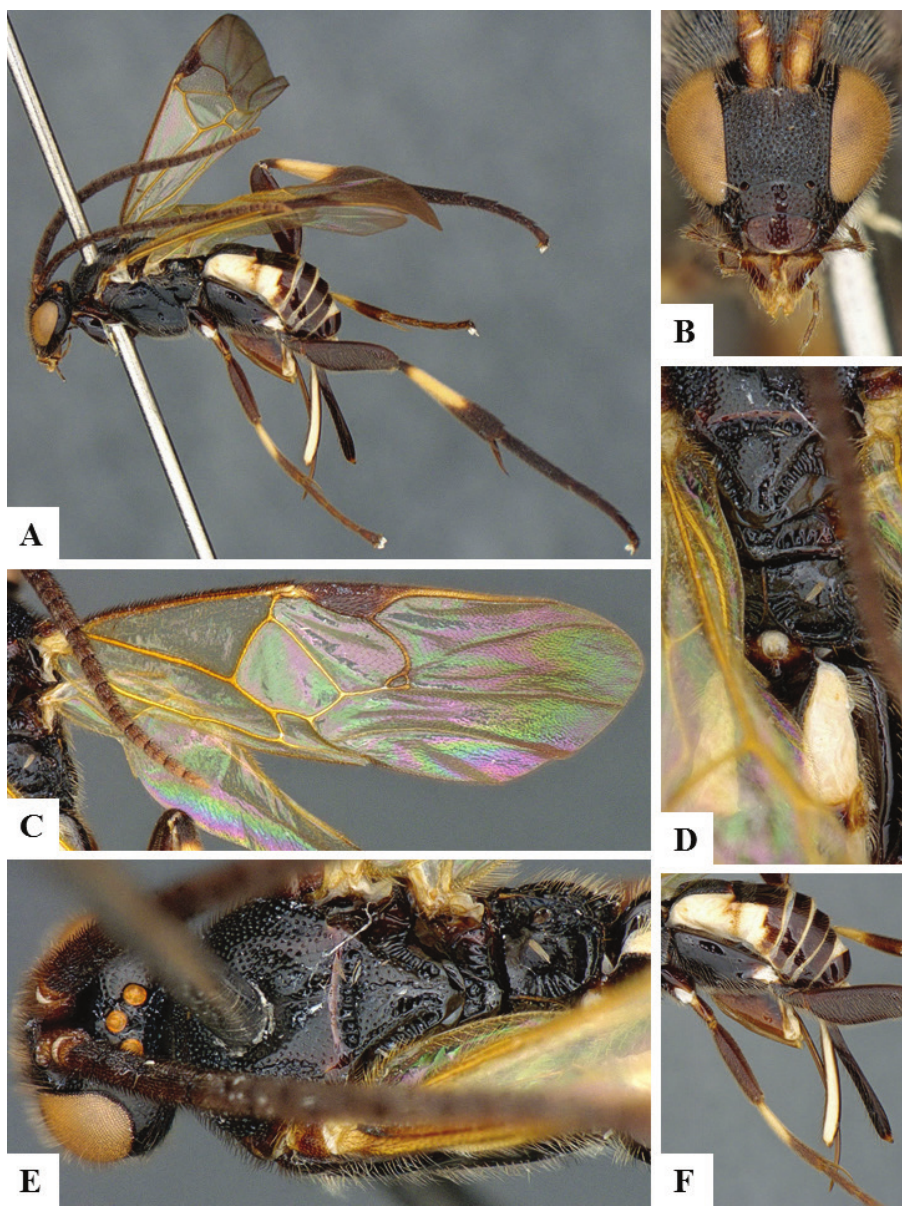
Figure 8. Agupta solangeae female paratype CNC497190. A Habitus B Head frontal C Fore wing D Propodeum E Head and mesosoma, dorsal F Ovipositor and ovipositor sheaths. F3 L: 0.41 (0.37–0.41); F14 L: 0.23 (0.21–0.24); F15 L: 0.21 (0.20–0.22); Malar sul- cus L: 0.13 (0.12–0.13); Mandible W: 0.23 (0.20–0.23); T1 L: 1.10 (1.00–1.05); T1 W at posterior margin: 0.33 (0.33–0.36); T1 maximum W: 0.62 (0.57–0.58); T2 W